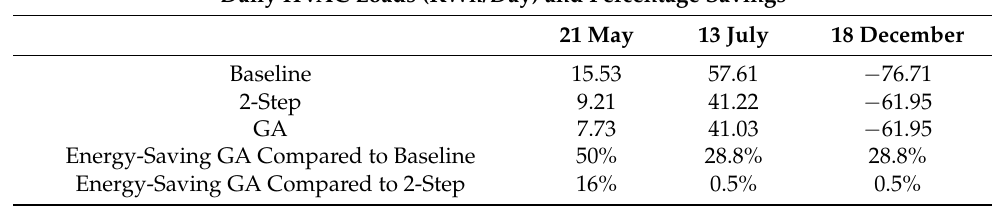
Table 3. HVAC loads for baseline windows and STIS–smart windows applied to a house in Golden, CO for three representative days: 21 May (swing season), 13 July (summer season), and 18 December (winter season) using two control strategies.